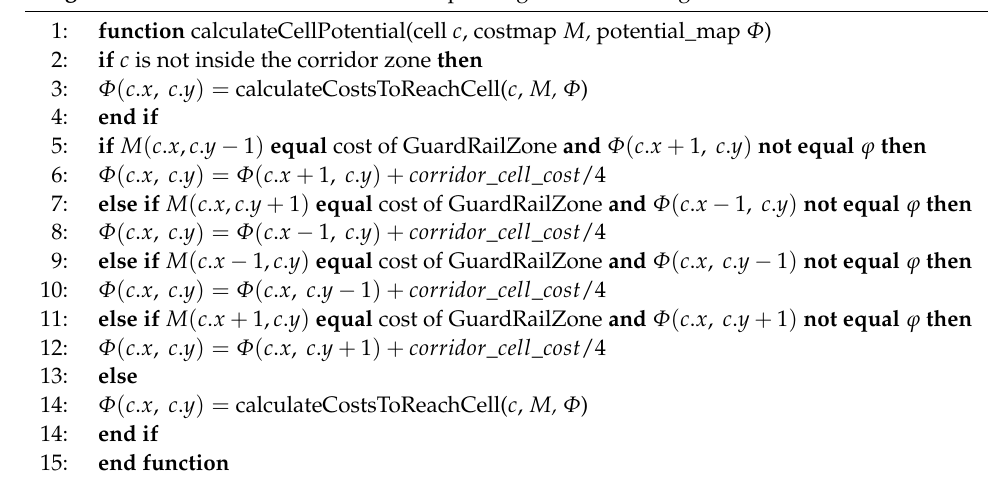
Algorithm 1. Calculation of Potential Map for right-hand